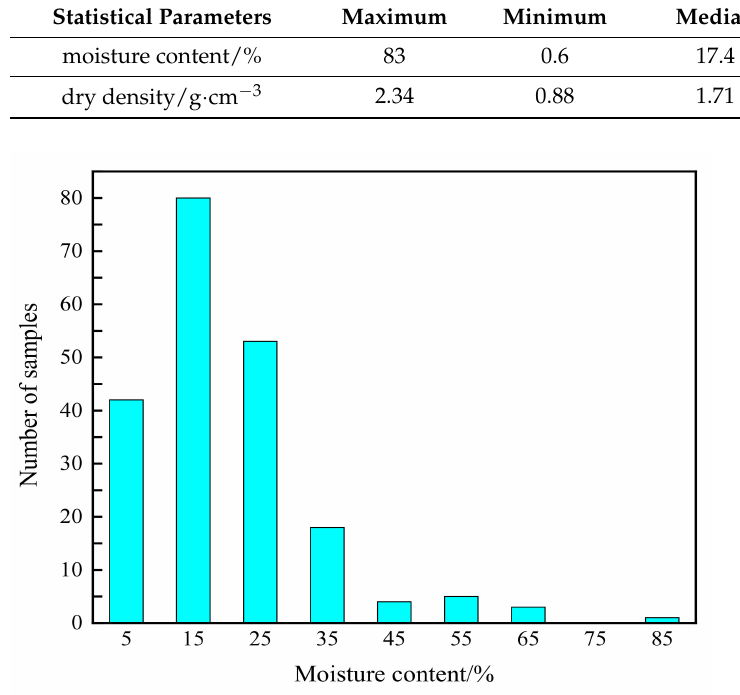
Figure 2. Moisture content distribution of tested sandy soil.